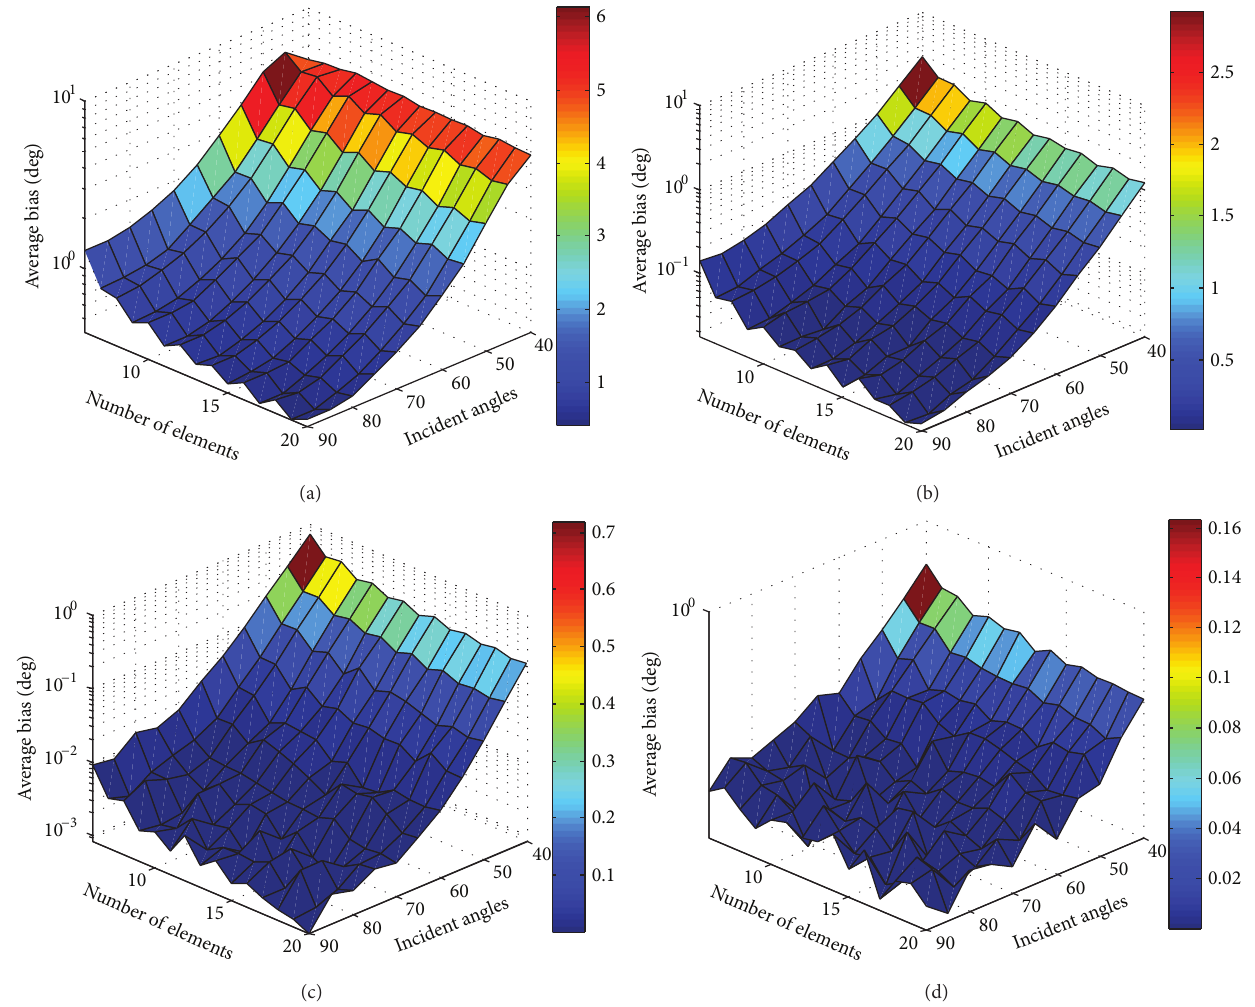
Figure 5: Summary of DOA estimations using MPM for a four-element ULA with the number of array elements varying from 6 to 20. Three equal-power incoming signals are from the directions of 𝜙 1 = 40 ∘ to 90 ∘ , 𝜙 2 = 𝜙 1 + 1 ∘ , and 𝜙 3 = 𝜙 1 + 2 ∘ with an SNR of 5 dB. The step size of Δ𝜙 1 = 5 ∘ is considered. The figures show the average biases of the estimated directions with array aperture (a) 0.75𝜆 , (b) 1.00𝜆 , (c) 1.25𝜆 , and (d) 1.50𝜆